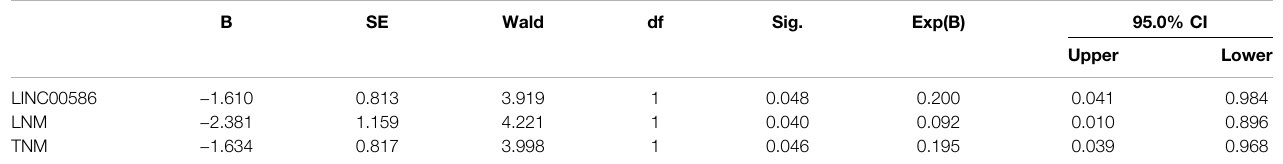
TABLE 3 | Cox regression analysis of independent prognostic factors for CRC. B SE Wald df Sig.